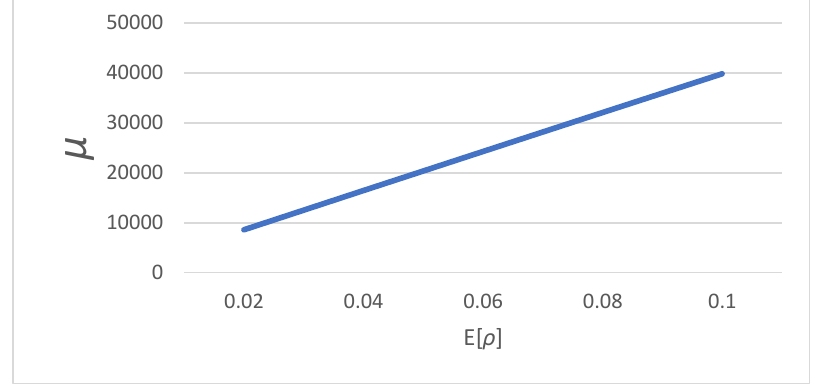
Figure 4. Effect of fraction of defective items ( 𝐸[𝜌] ) on optimal order quantity ( 𝜇 ∗ )